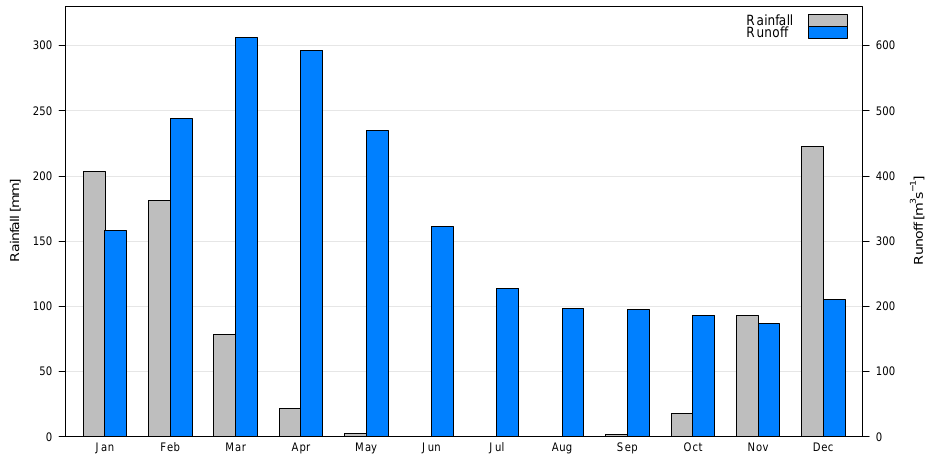
Figure 2. Mean monthly rainfall from WorldClim [41] for the Kafue River basin and mean monthly runoff at Itezhi-Tezhi for the period 1978–1991 (source: